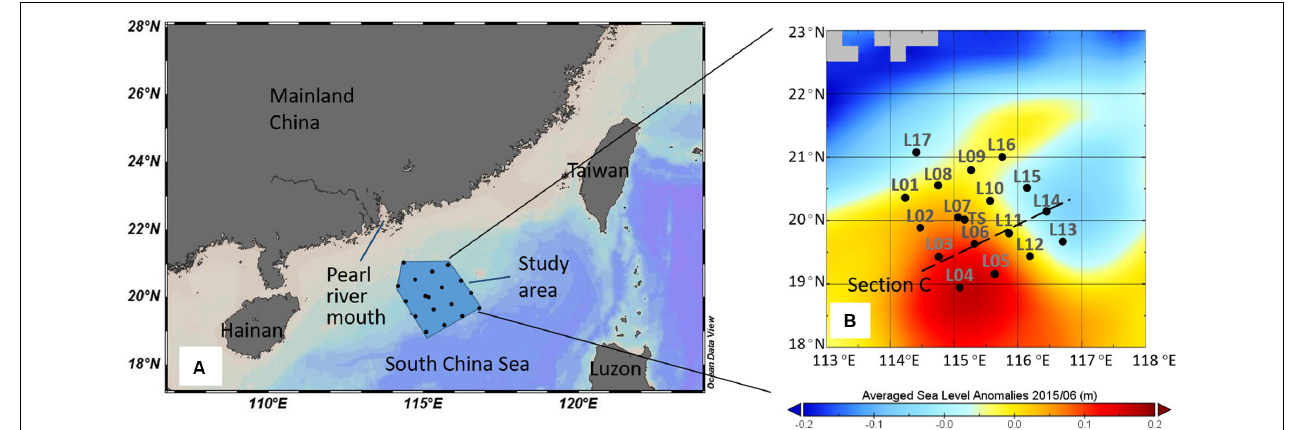
FIGURE 1 | Study area in the South China Sea (A) and sampling stations in June 2015 (B) . The color in (B) represented the averaged sea level anomalies in June 2015